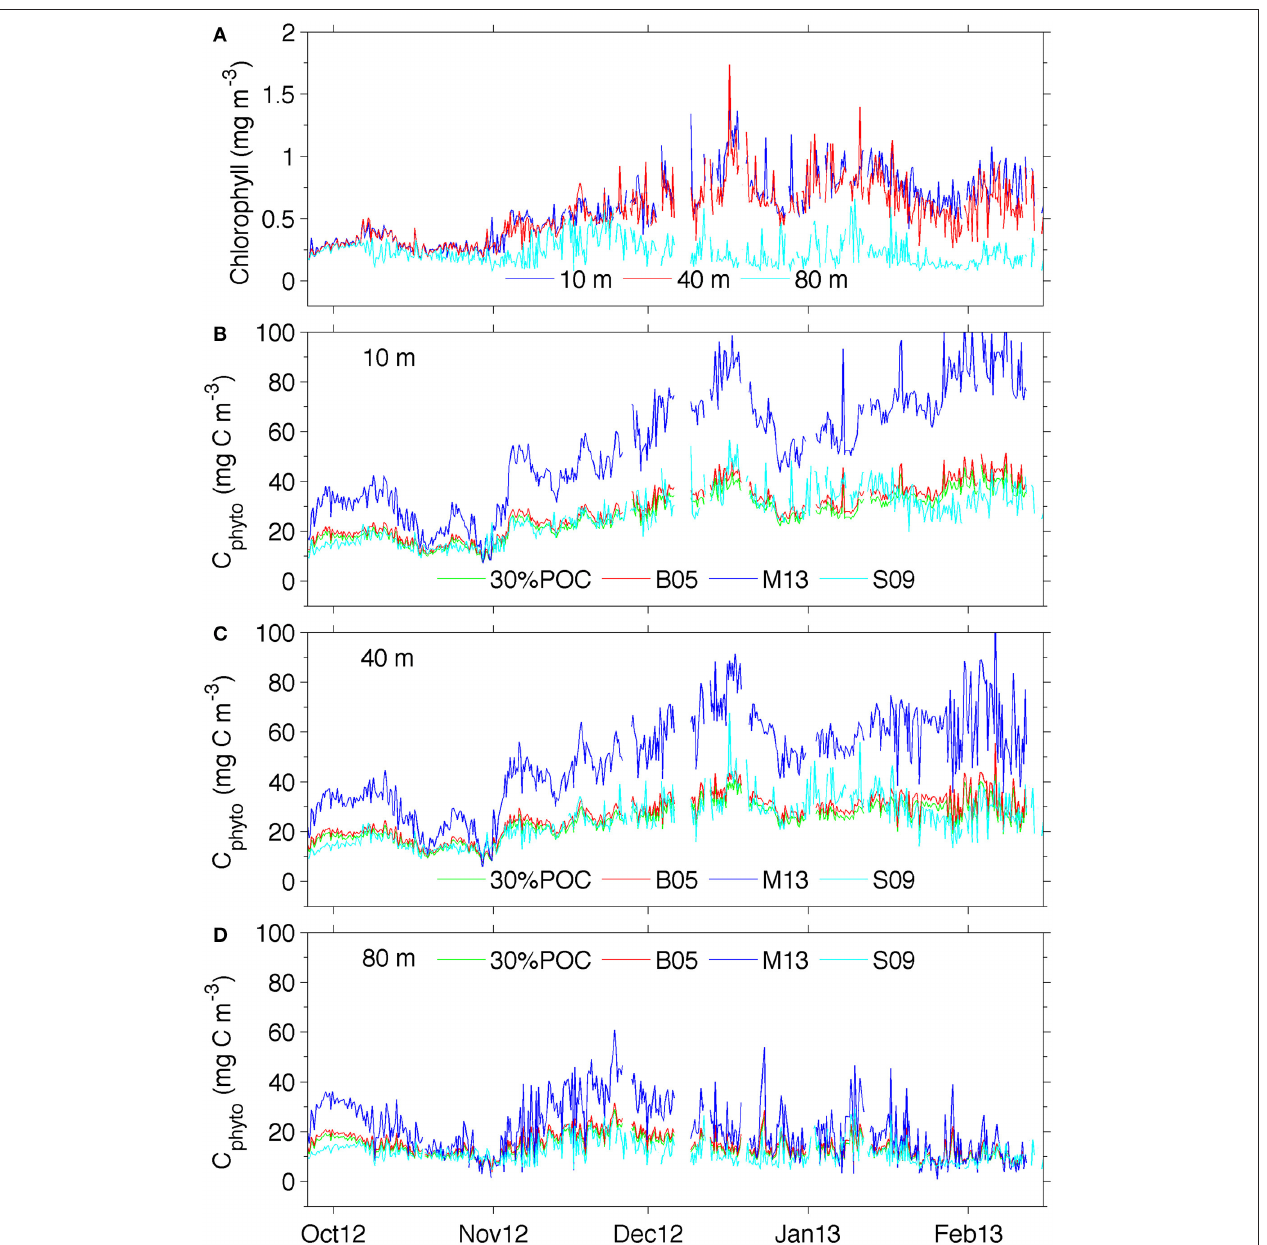
FIGURE 5 | (A) Temporal chlorophyll distribution at different depths and (B) temporal distribution of phytoplankton carbon at 10 m, (C) 40m and (D) 80m See supplementary Figure 3 for a version of panel (B) showing the ranges derived from using the standard error of the estimates for 30%POC equation (2), M13 equation (4), and S09 equation